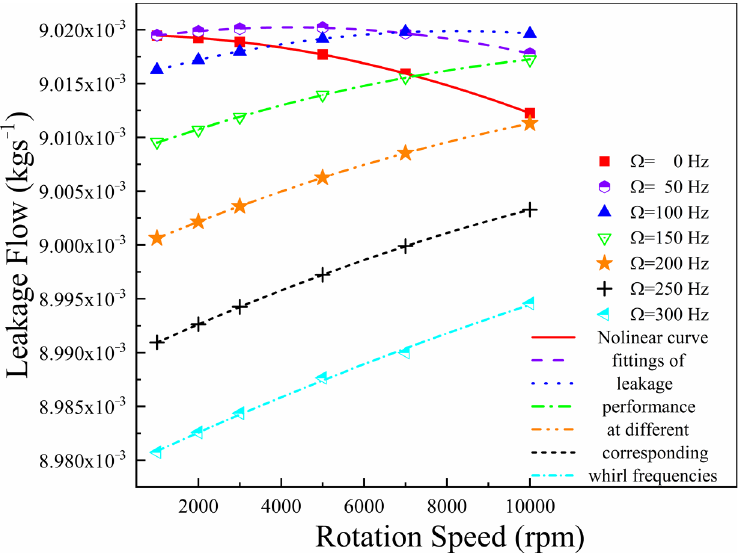
Figure 22. Nonlinear curve fittings of leakage flow at different whirl frequencies.